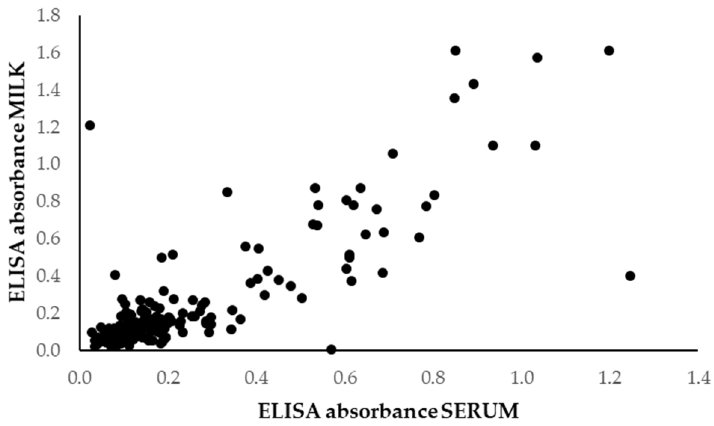
Figure 1. CAE-ELISA absorbance values in serum ( x -axis) vs. milk ( y -axis) in 212 lactating goats included in the study to estimate the occurrence of CAE and CLA (Sweden,